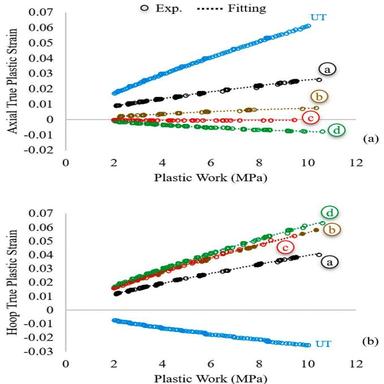
The calculated principal plastic strains for different levels of plastic work for uniaxial tension and biaxial tension deformation modes: a) Axial plastic strain and b) Hoop plastic strain with respect to the plastic work (The experimental data were fitted using polynomial functions).